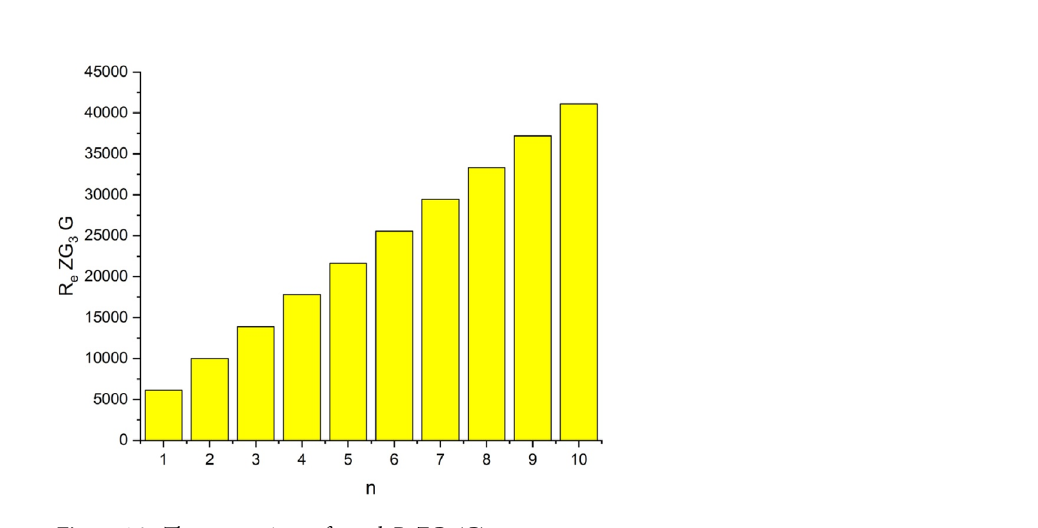
Figure 16. The comparison of n and . R e ZG 3 ( G )